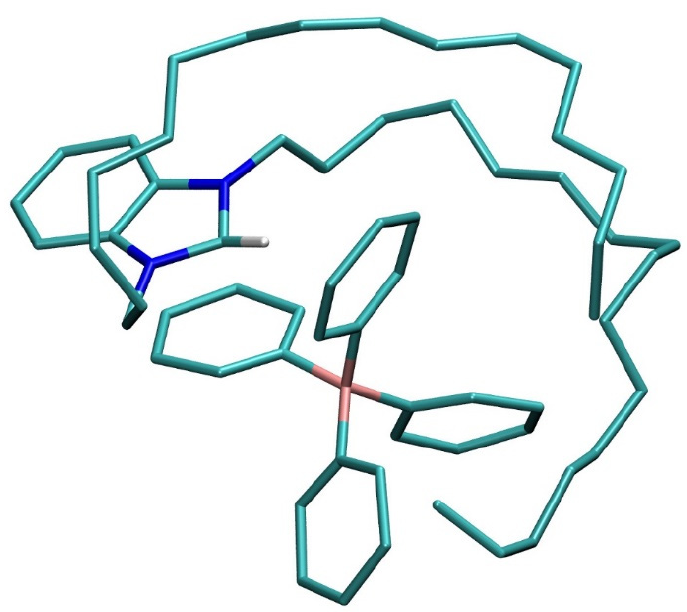
Figure 1. The representative structure of the DHBI-TPB complex in the aqueous solution, with hydrogen atoms omitted due to clarity.